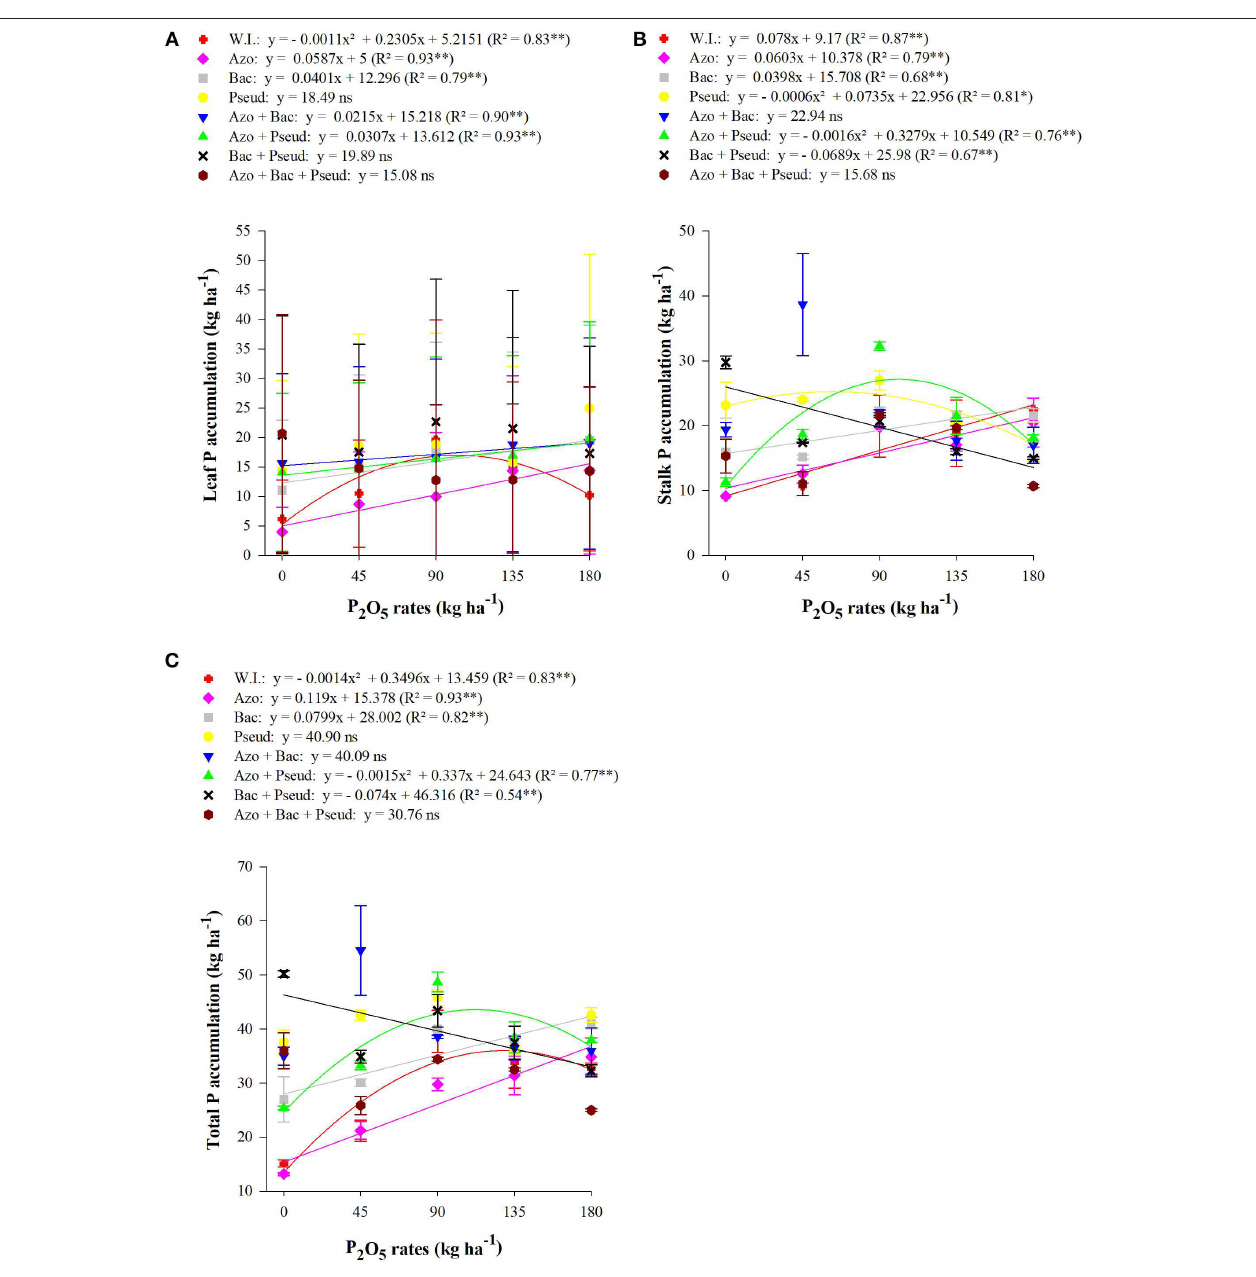
FIGURE 4 | Interactions between different bacterial inoculations and P 2 O 5 doses for leaf P accumulation (A) , stalk P accumulation (B) and total P accumulation (C) , at the end cycle of the plant-cane, RB92579 variety (Mean values ± standard deviation). **, * and ns: significant at 1 and 5% at p < 0.01, 0.01 < p < 0.05, and not significant, respectively. W.I., without inoculation; Azo, Azospirillum brasilense ; Bac, Bacillus subtilis ; Pseud, Pseudomonas fluorescens ; Azo + Bac, A. brasilense + B. subtilis ; Azo + Pseud, A. brasilense + P. fluorescens ; Bac + Pseud, B. subtilis + P. fluorescens ; Azo + Bac + Pseud, A. brasilense + B. subtilis + P. fluorescens .